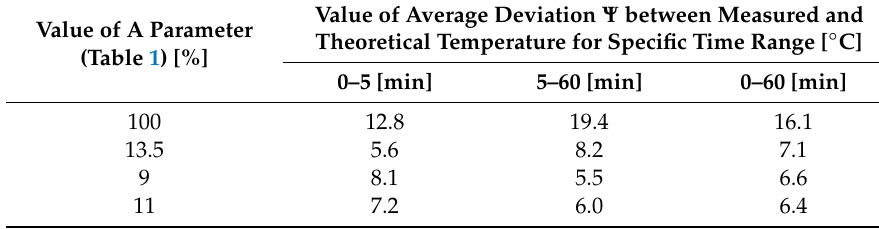
Table 5. Value of average deviation Ψ between the measured and theoretical temperature for the assumed A parameter and 6 L / m 2 / h of water. Value of Average Deviation Ψ between Measured and Value of A Parameter Theoretical Temperature for Specific Time Range [ ◦ (Table 1) [%]